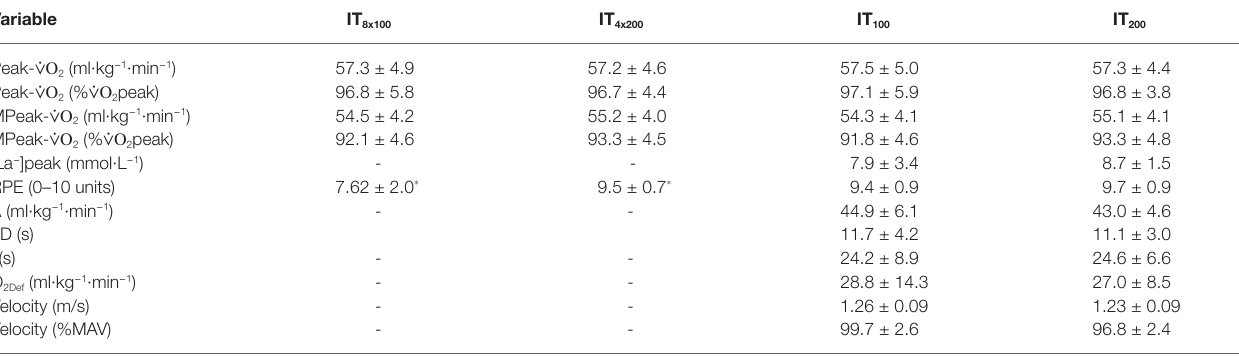
TABLE 3 | Mean ± SD of the physiological and perceptual responses during the IT protocols, and ⩒O 2 kinetics ( ⩒O 2 K) during the first bout of IT 100 and IT 200 ( N = 12). Variable IT 8x100 IT 4x200 IT